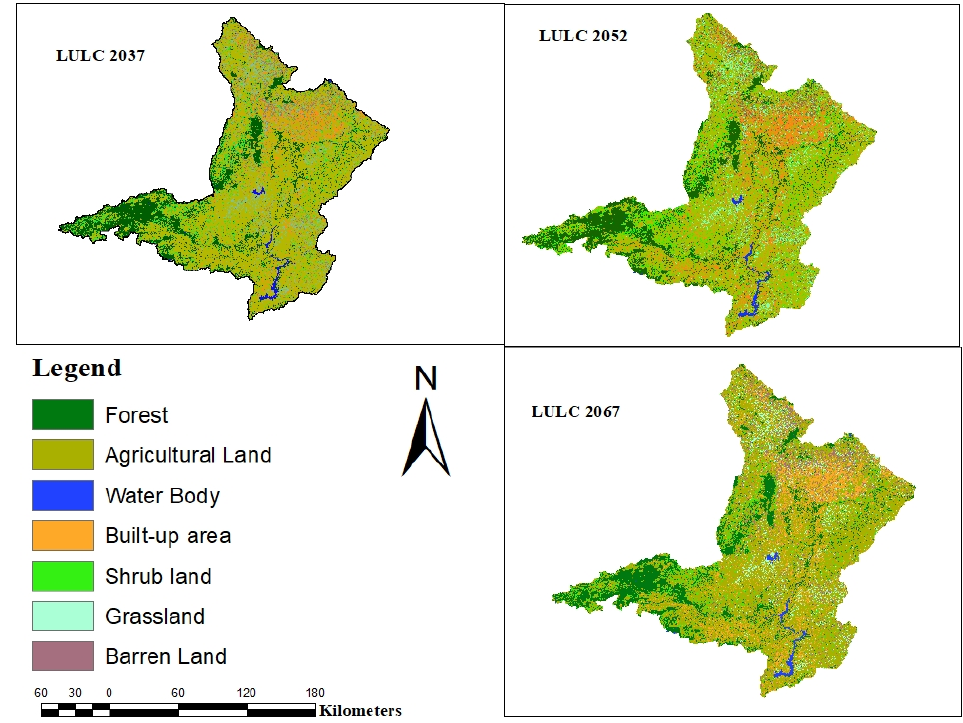
Figure 10. Prediction of LULC (2037–2067). Table 10. Area in km2 for the LULC (2037, 2052, and 2067) .